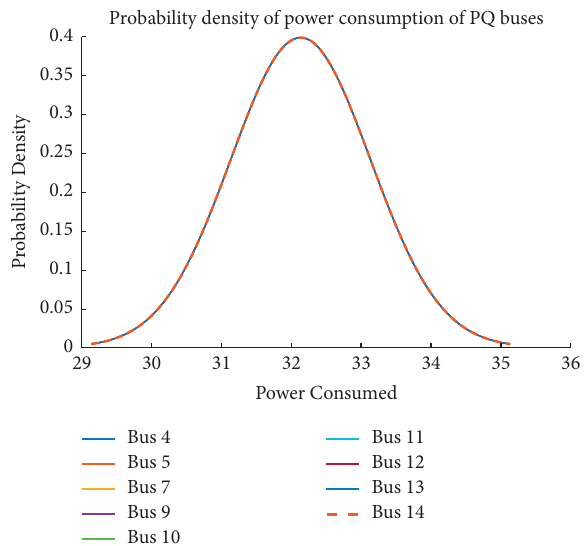
Probability density of power consumption of PQ buses